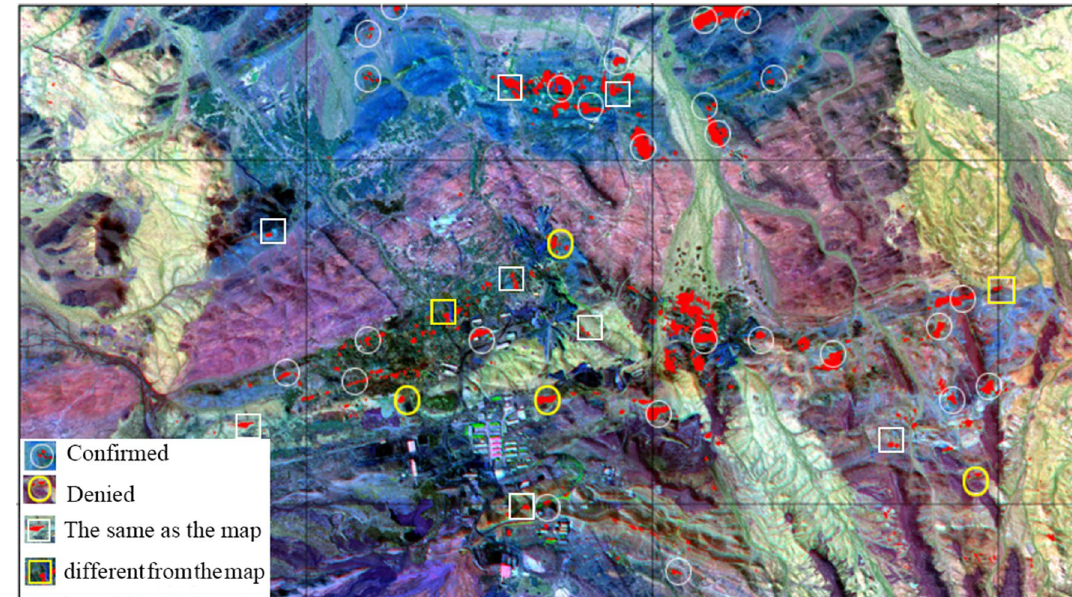
Figure 6. Distribution and results of verification points of deposit and mineralization information. This figure is generated by Mou-shun Jin, Yu-Hai Fan using ENVI (version4.3) created by the ENVI Team under an open license (http://www.envii